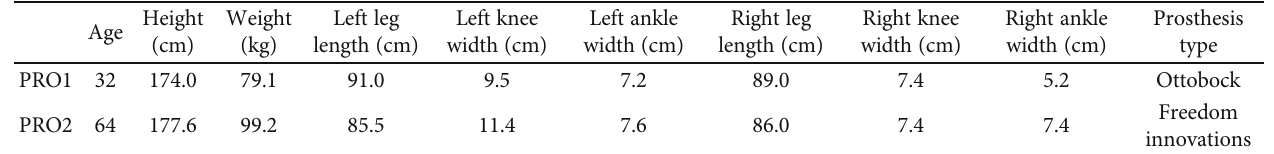
Table 2: Demographic and anthropometric data for the subjects who were prosthesis